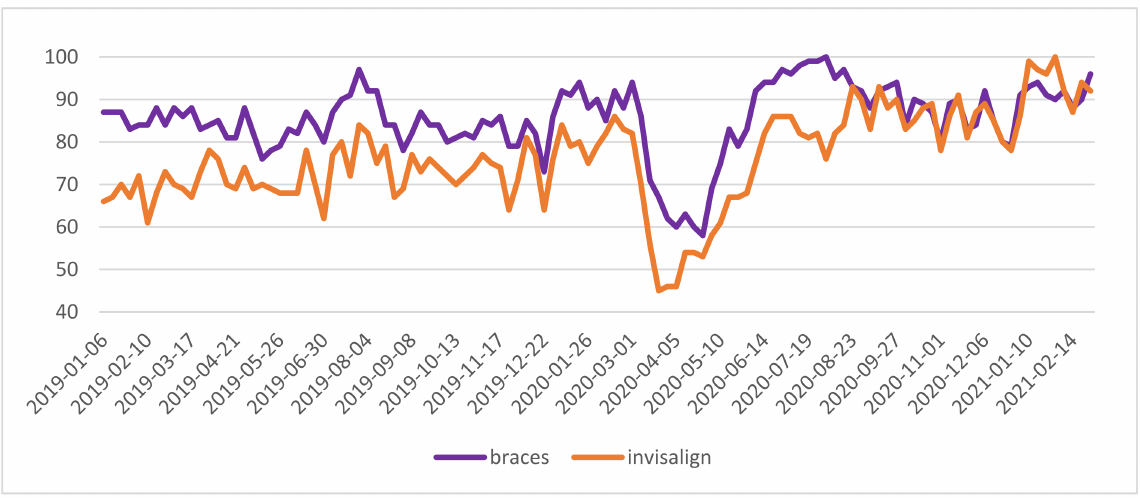
Figure 2. “braces” and “invisalign” phrases—relative search